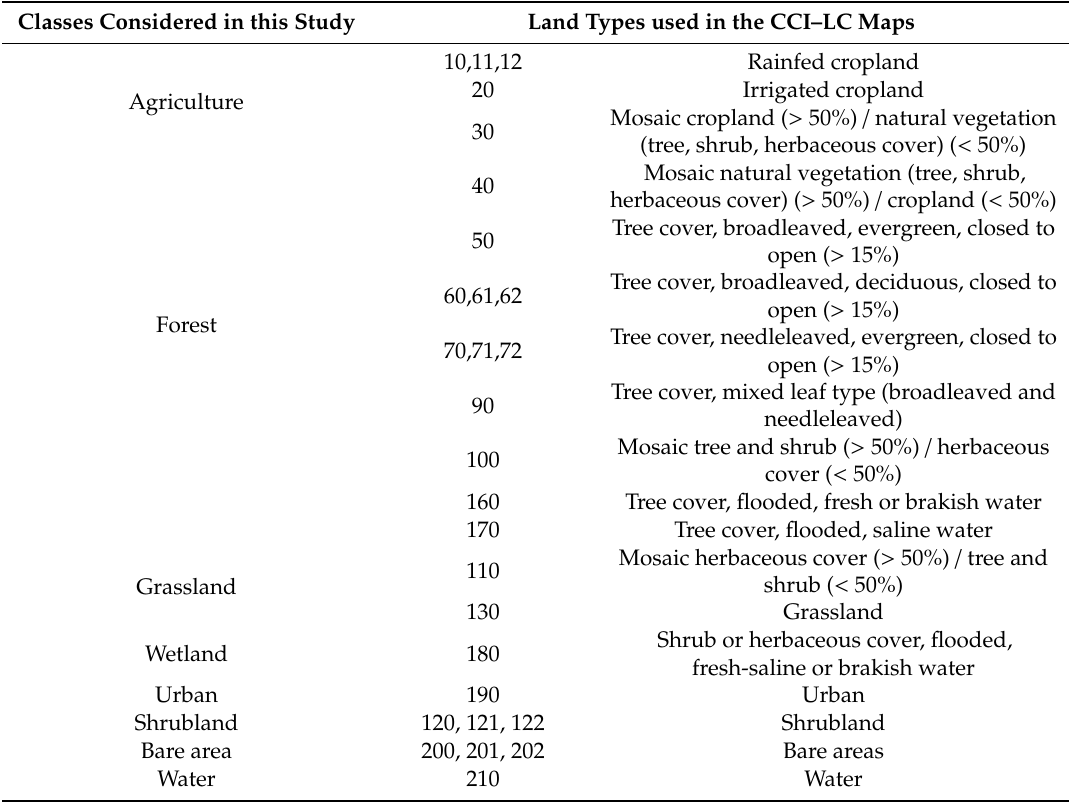
Table A1. A look up table for reclassification of land cover types (adapted from Land Cover CCI: product user guide, Version